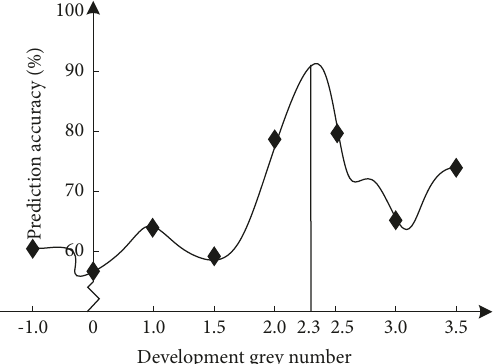
Figure 5: Development grey number change